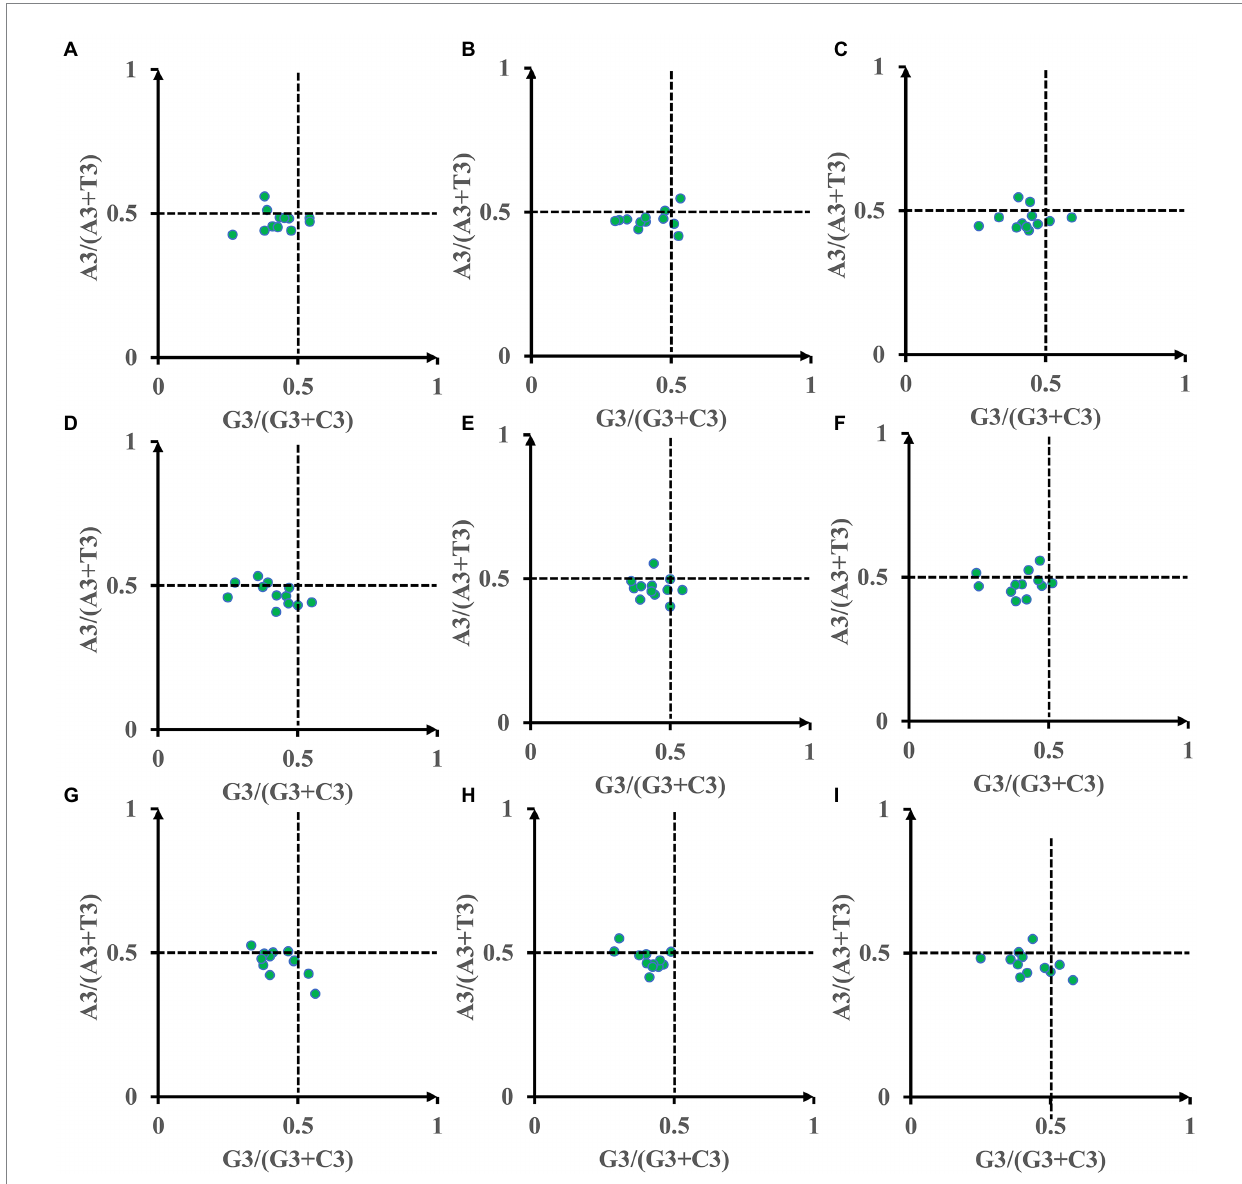
FIGURE 5 Parity Rule 2 (PR2) plot analysis of 12 core PCGs in 9 Amanita species. (A) , A. basii ; (B) , A. bisporigera ; (C) , A. brunnescens ; (D) , A. muscaria ; (E) , A. phalloides ; (F) , A. pseudoporphyria ; (G) , A. sinensis ; (H) , A. inopinata ; and (I) , A. thiersii